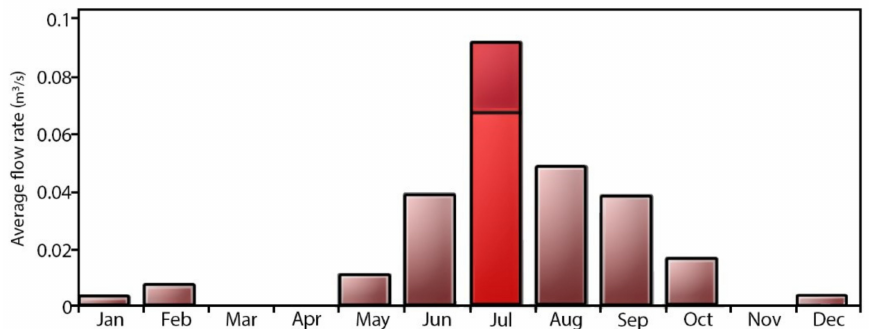
Figure 11. Regime of flow rate of minimal monthly reference for “La Yerbabuena” stream. Red color in July indicates the highest